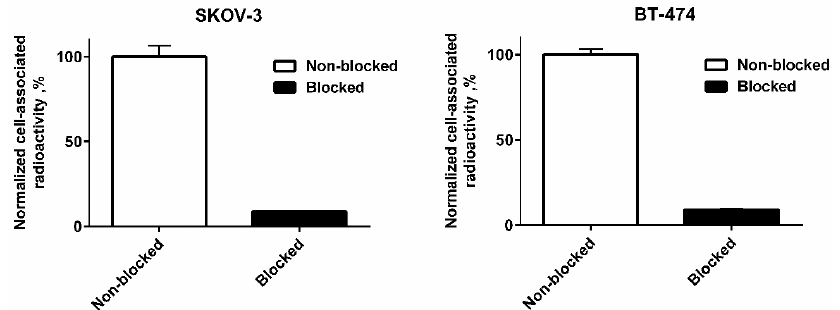
Figure 5. In vitro binding specificity of [ 99m Tc]Tc-AC12-GGGC on SKOV-3 and BT-474 cell lines. For the pre-saturation of B7-H3, a 200-fold molar excess of a non-labelled Affibody molecule was added before adding the labelled conjugate. Data are normalized to the average value of cell-associated radioactivity for non-blocked cells for each cell line. The data are presented as an average value from three samples ± SD.